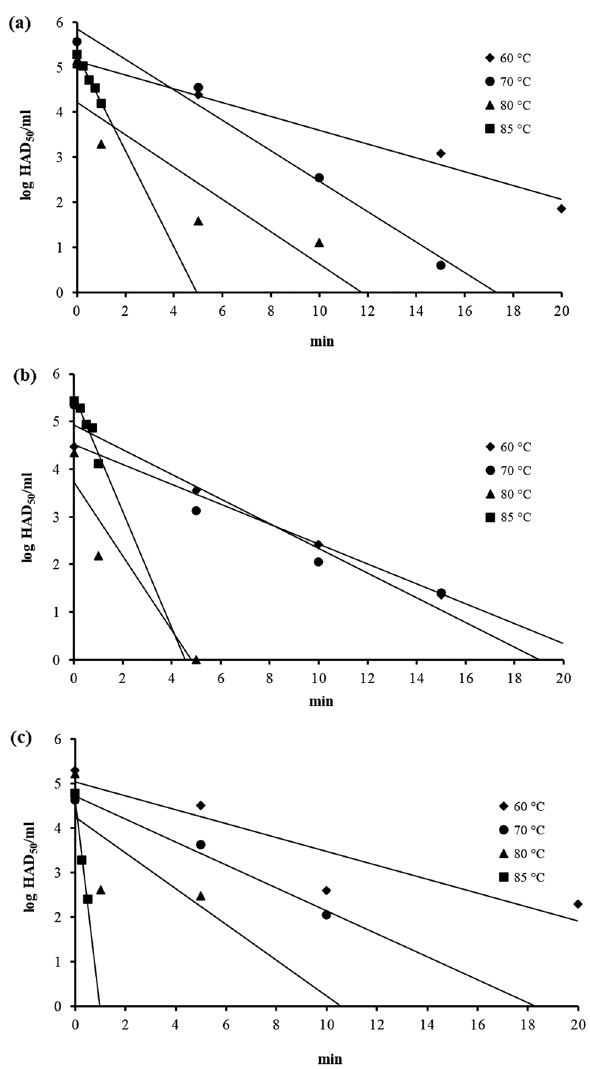
Figure 1. Thermal inactivation of ASFV at 60, 70, 80, and 85 °C in MBM a SBM b MZ c.